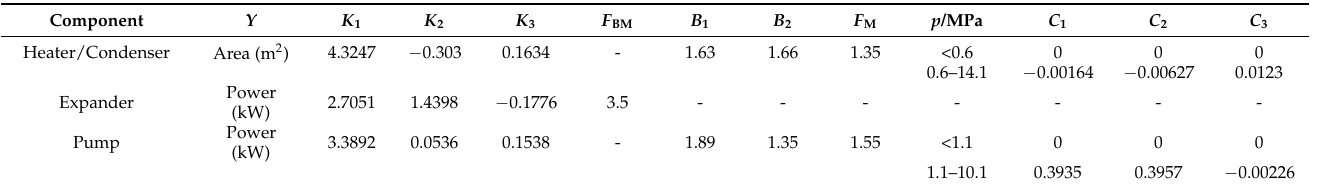
Table 2. Parameters in Equations (26) and